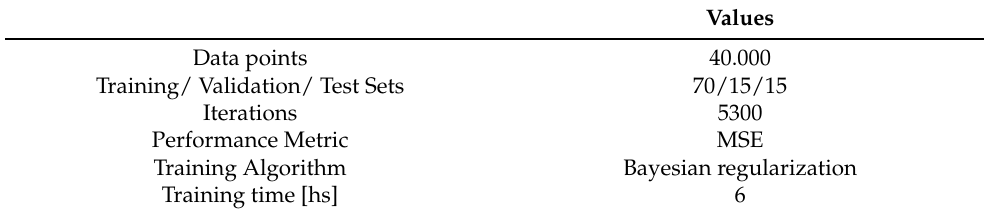
Table 3. ANN specifications.